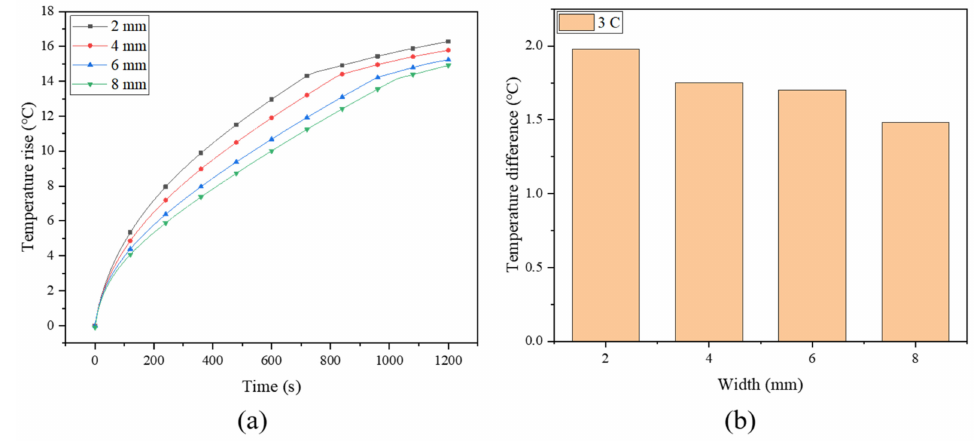
Figure 7. ( a ) The maximum temperature rise and ( b ) temperature difference of battery with different fin